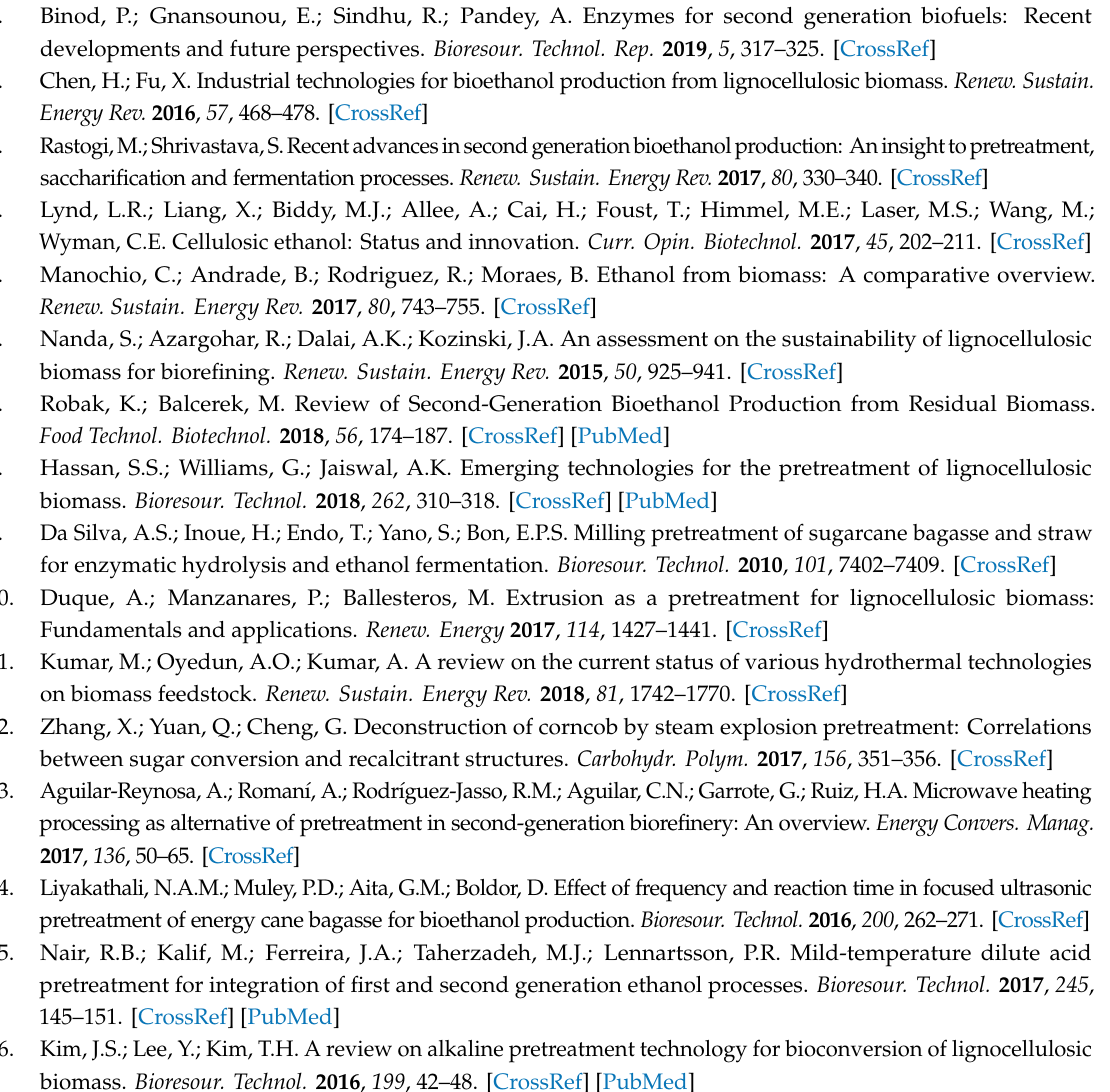
Figure S1: ATR-FTIR spectra of the solid fraction recovered after alkali and acid pretreatments at 160 ◦ C for 20 min; Table S1: Solid fraction recovery of pretreated SCB as a function of pretreatment conditions; Table S2: Saccharide composition of SCB hydrolysate as a function of pretreatment conditions; Table S3: Ethanol produced by fermentation of pretreated SCB hydrolysate as a function of pretreatment